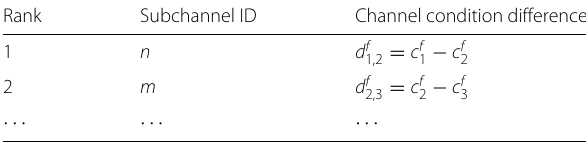
Table 3 Channel condition difference table (CCDT) for FBS f Rank Subchannel ID Channel condition